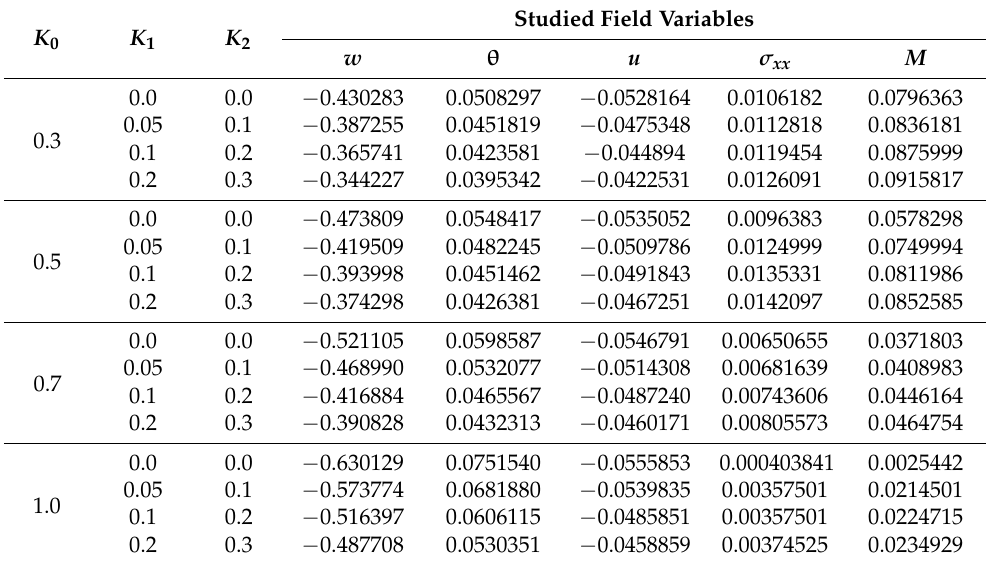
Table 1. Dimensionless physical field variables with Winkler basis ( K 1 ), Pasternak foundation ( K 2 ), and viscous damping coefficient ( K 0